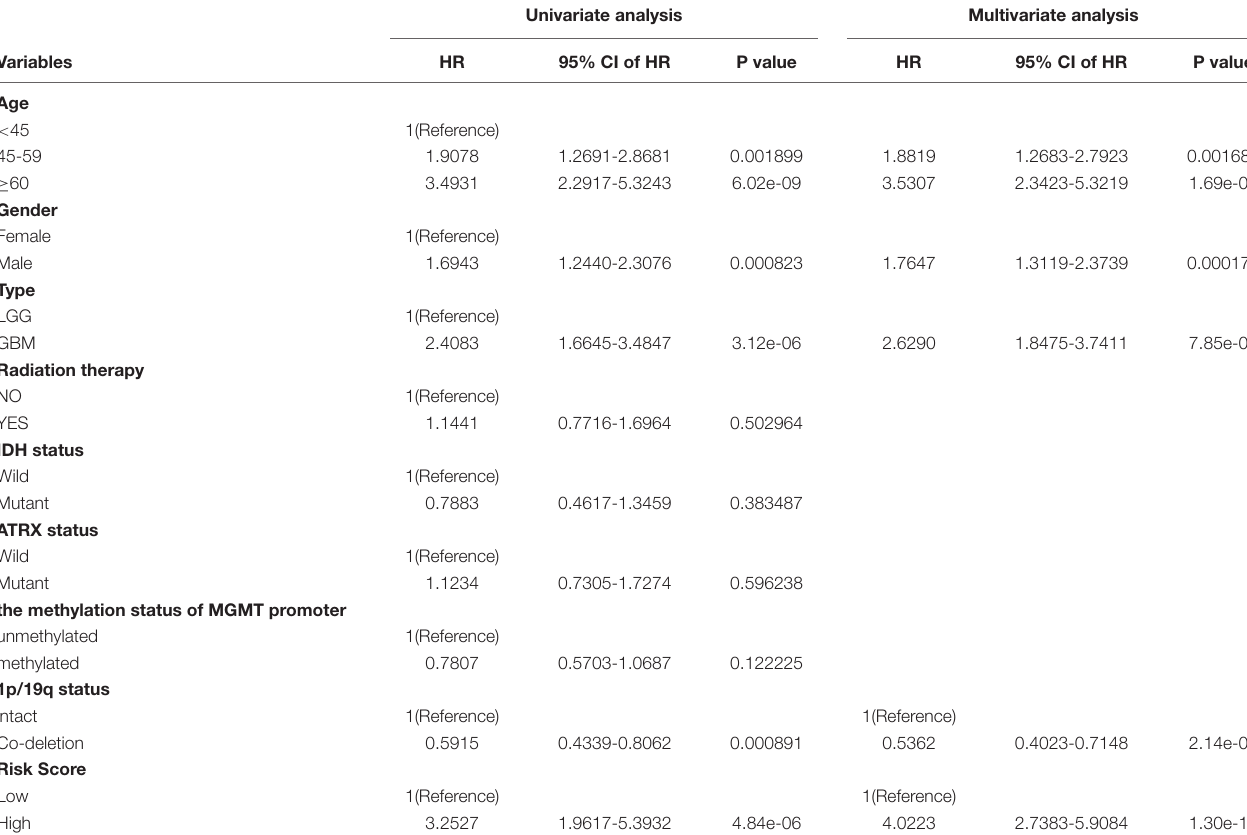
TABLE 2 | The univariable and multivariable Cox regression analysis of the 8-DNA methylation signature in glioma patients. Univariate analysis Multivariate